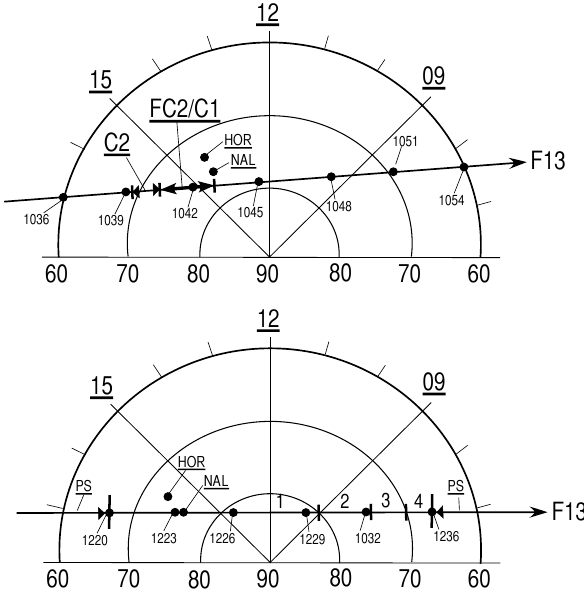
Fig. 8. The observation geometry showing tracks of satellites DMSP F13 across the polar cap from dusk to dawn during the in- tervals 10:36–10:54UT (top panel) and 12:20–12:36UT (bottom). The locations of two ground stations on Svalbard (NAL: 76 ◦ MLAT; HOR: 74 ◦ MLAT) at 10:43UT (top) and 12:24UT (bottom) are marked by dots. These times correspond to the closest approaches of DMSP F13 to station NAL. The plasma flow feature (FC 2) and Birkeland current regimes C1 (inward-directed) and C2 (outward- directed) are marked along the track in the top panel. Satellite entry into the polar cap (plasma sheet-polar rain preciptation boundary) at 12:20UT and exit at 12:36UT have been marked in the bottom panel. The coordinate system is MLT/MLAT.